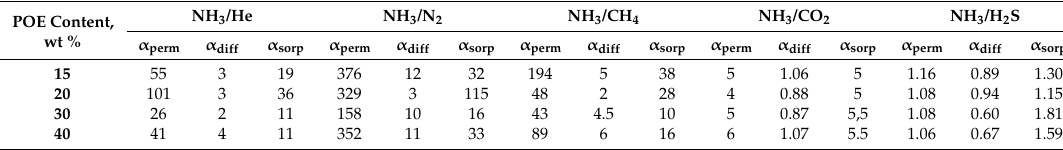
Table 4. Ideal selectivity for NH 3 /gas systems for polymer membranes obtained at different POE block contents.